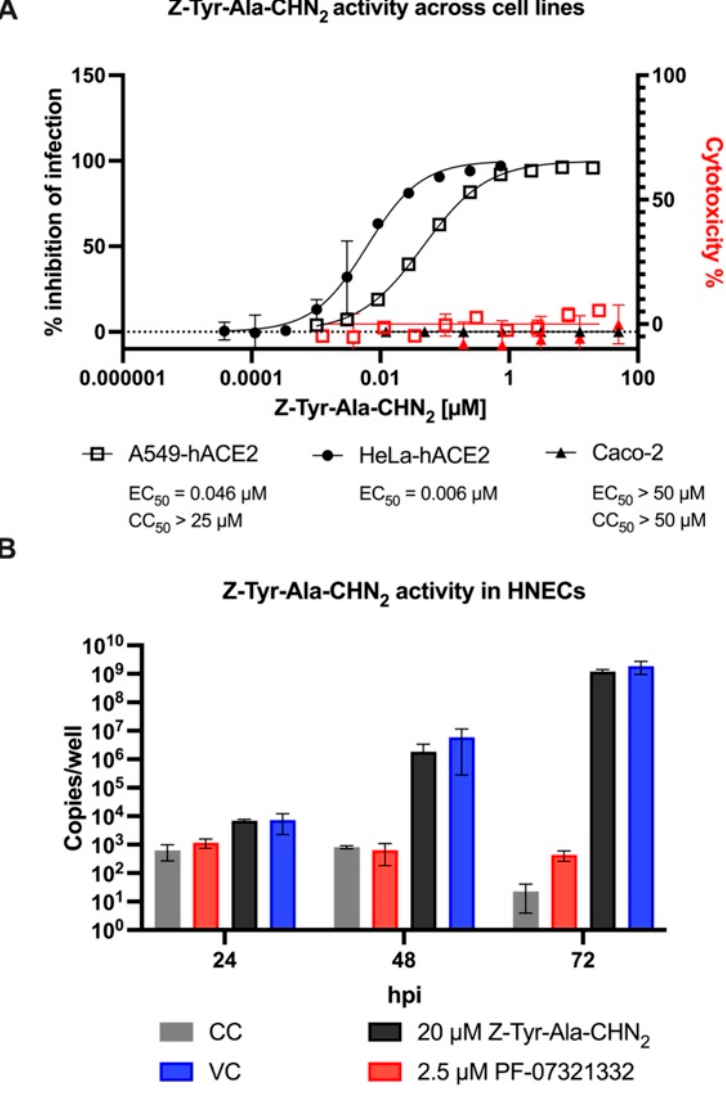
Figure 4. ( A ) The antiviral activity of Z-Tyr-Ala-CHN 2 against SARS-CoV-2 in A549-hACE2 (black, empty squares), HeLa-hACE2 (black, full circles), and Caco-2 (black, full triangles) cells. The mean values ± SD are shown of three (A549-hACE2 and HeLa-hACE2) to six (Caco-2) independent experiments. Cytotoxicity was determined in A549-hACE2 (red, empty squares) using ATPlite and in Caco-2 (red, full triangles) using Rotitest ® Vital. The mean values ± SD are shown from two (A549-hACE2) to six (Caco-2) independent experiments. ( B ) Z-Tyr-Ala-CHN 2 does not inhibit SARS-CoV-2 infection in an upper respiratory tract model. HNEC ALI cultures were infected with SARS-CoV-2 and treated with PF-07321332 at 2.5 µ M (red) and Z-Tyr-Ala-CHN 2 at 20 µ M (black). Cell control (CC; (gray bars, DMSO 0.2%); Virus control (VC; blue bars, MOI 0.1 without compound). The mean ± SD from within one representative experiment is shown. Within each experiment, conditions are performed in duplicate. ALI, air-liquid interface; HNEC, human nasal epithelial cell; MOI, multiplicity of